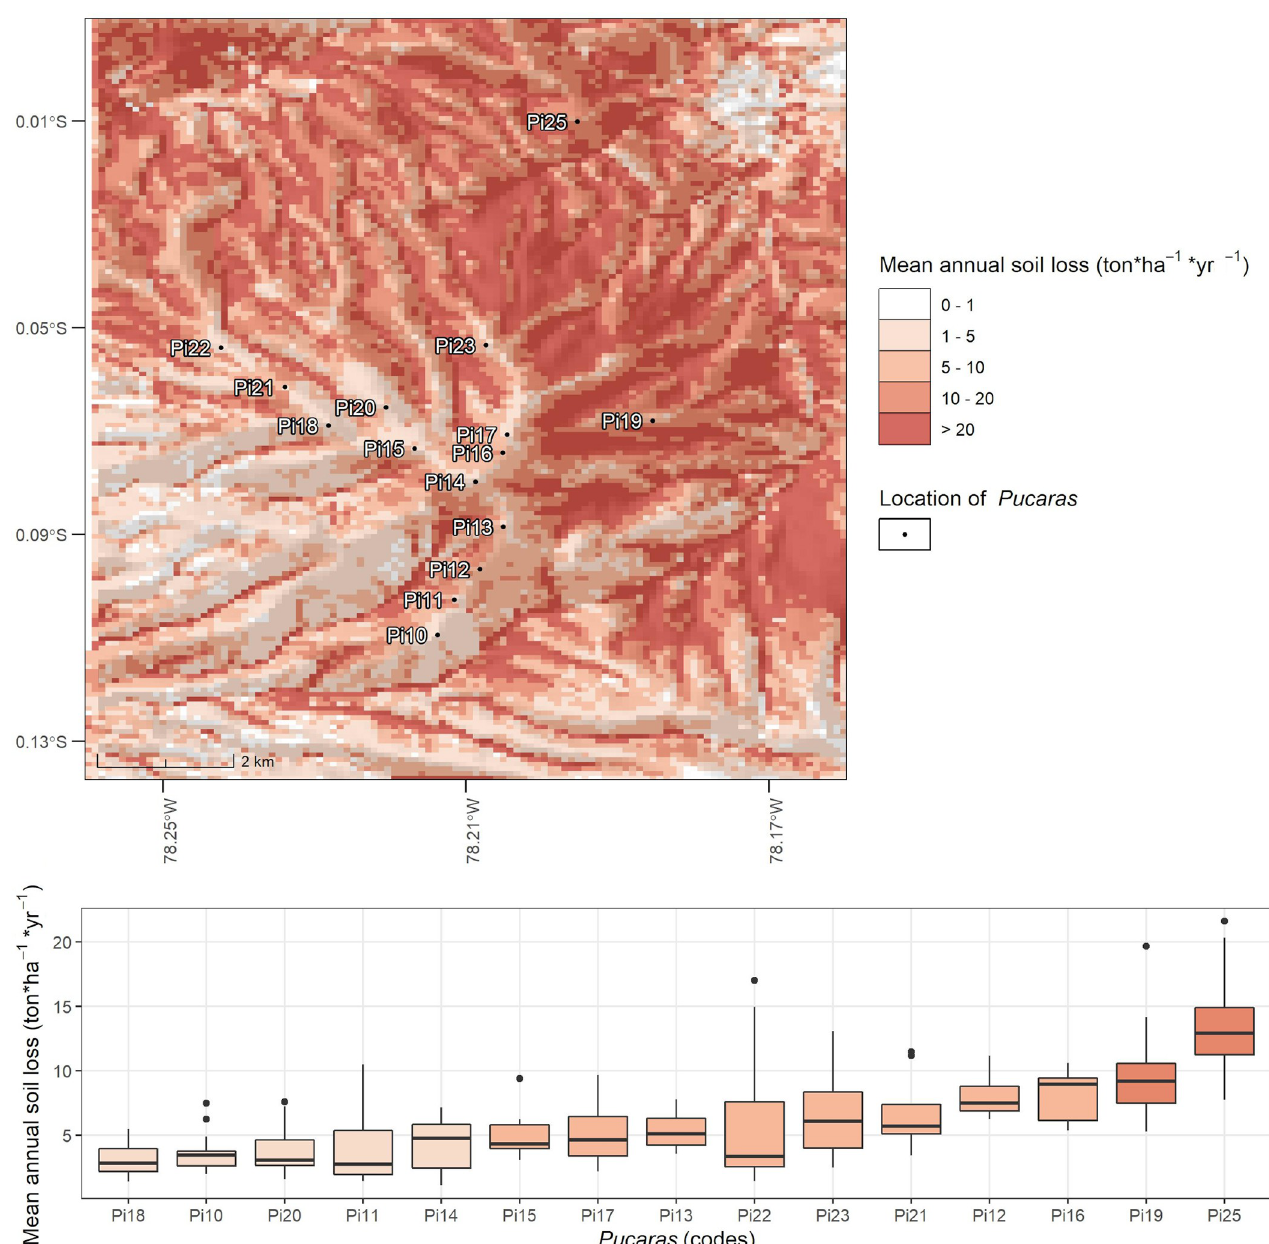
Fig 4. Spatial representation of the mean annual soil loss derived from the historical rainfall R-factor using the RUSLE model. Bottom: Boxplots of values observed in the buffer area of Pucaras .